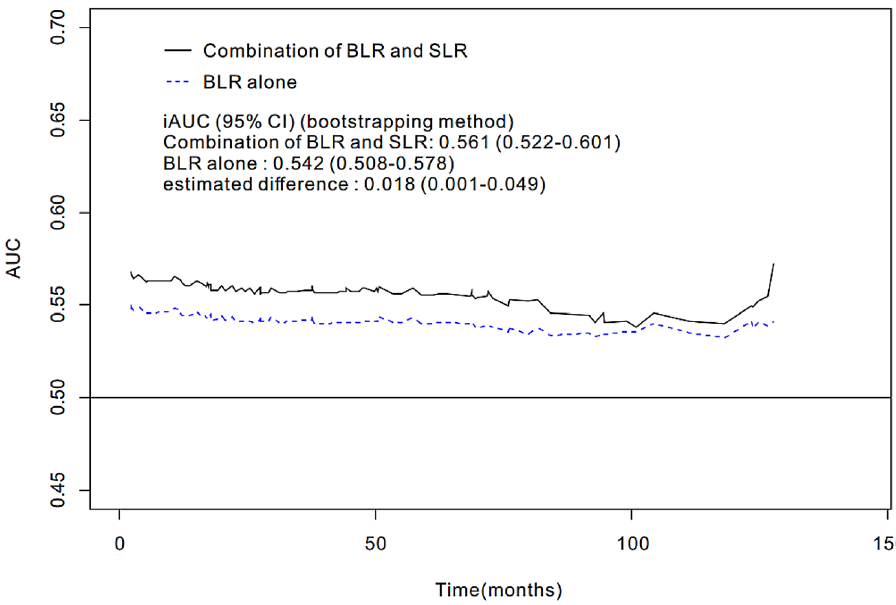
Figure 3. Comparison of integrated AUC (iAUC) between four-group stratification by the combination of BLR and SLR, and between two-group by BLR alone.